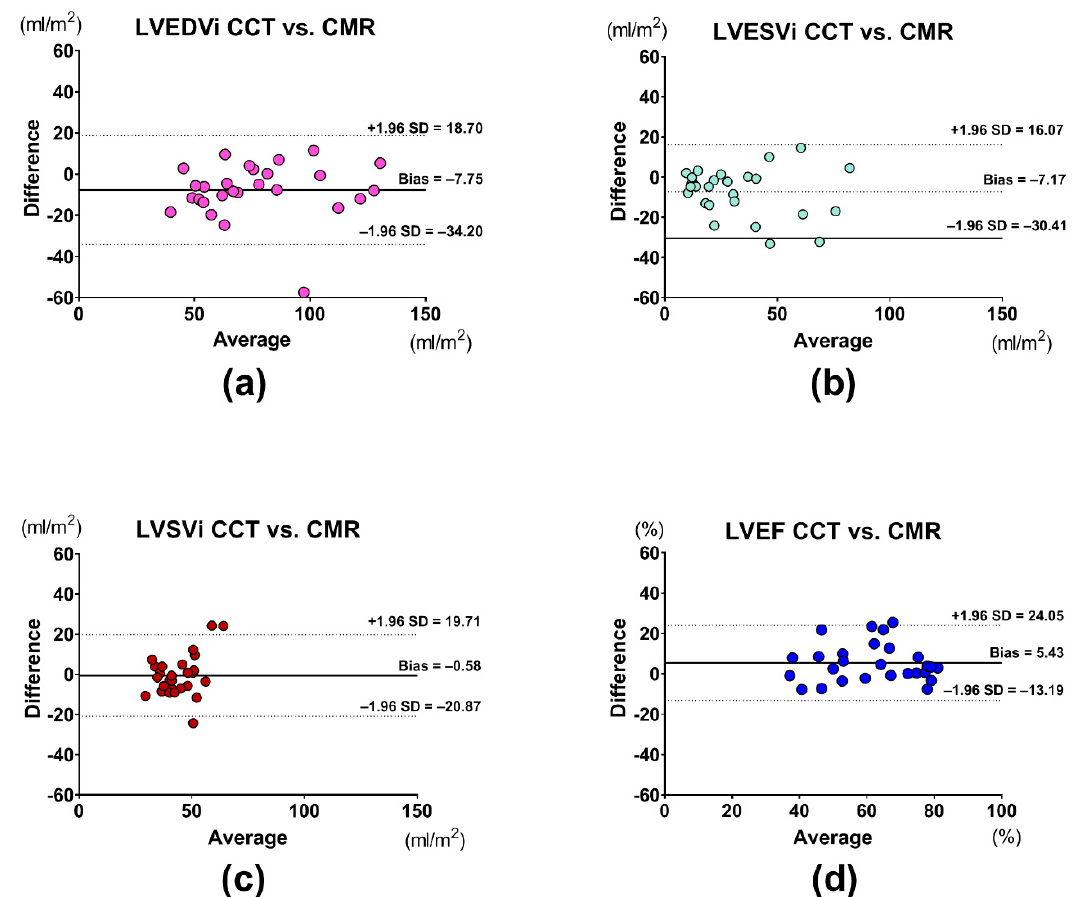
Figure 1. Bland–Altman analyses of ( a ) LVEDVi, ( b ) LVESVi, ( c ) LVSVi, and ( d ) LVEF assessment between CMR and CCT. Abbreviations: CCT: cardiac computed tomography; CMR: cardiac magnetic resonance; LVEF: left ventricular ejection fraction; LVEDVi: left ventricular end-diastolic volume index; LVESVi: left ventricular end-systolic volume index; LVSVi: left ventricular stroke volume index.